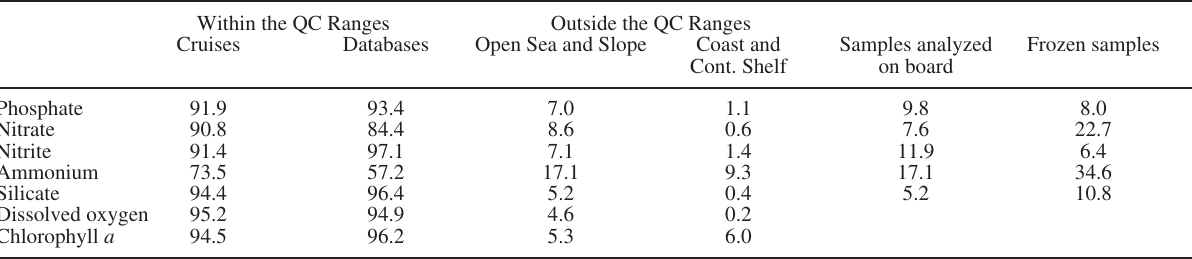
Table 19. – Proportion (%) of the data gathered that is found within and outside the quality control ranges defined in this